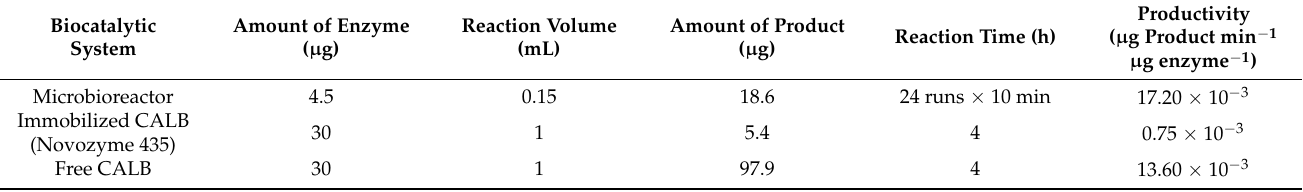
Table 4. Comparative data for the transesterification of ethyl ferulate with glycerol in microreactor and batch